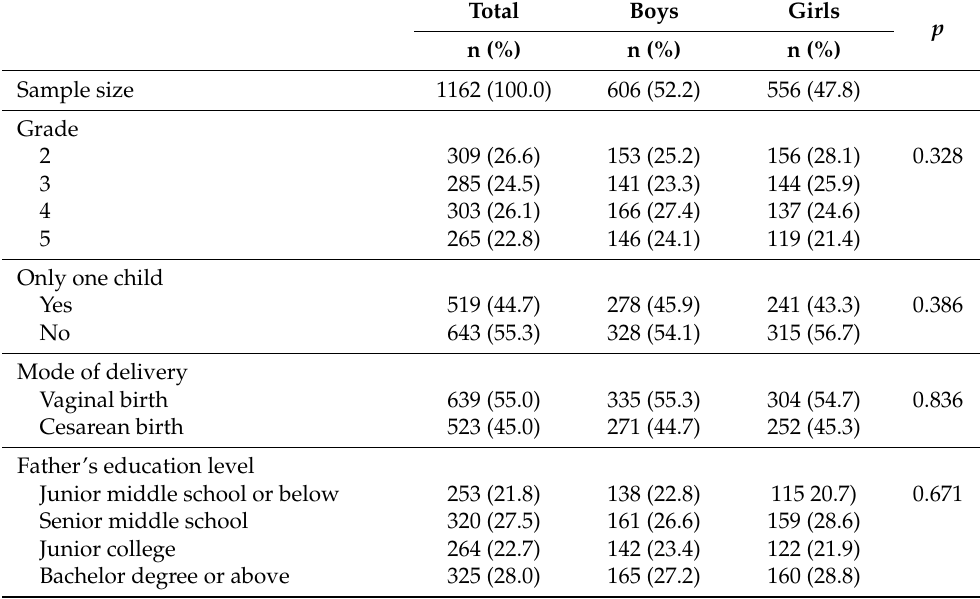
Table 1. Demographic information of the subjects (N =